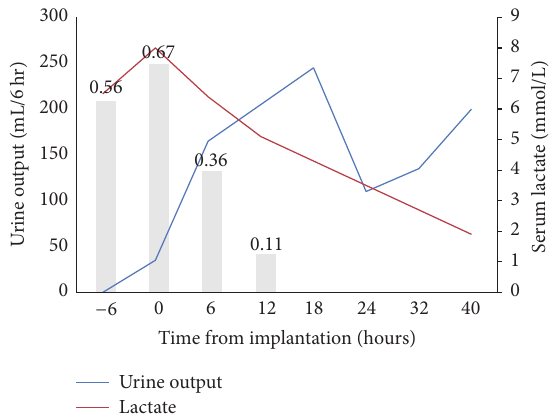
Figure 2: Graphic trend of urine output (blue line), serum lactate (red line), and total vasopressor requirement (gray bars) at six-hour intervals from Impella deployment. ∗ Total vasopressor requirement expressed in mcg/kg/min, as calculated by norepinephrine dose equivalence